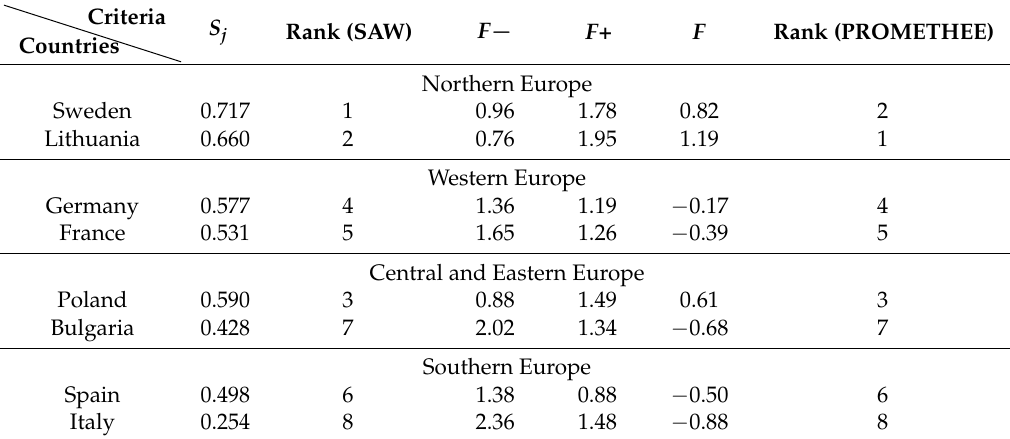
Table 11. Results of evaluation by the SAW and the PROMETHEE (preference ranking organization method for enrichment evaluation) II